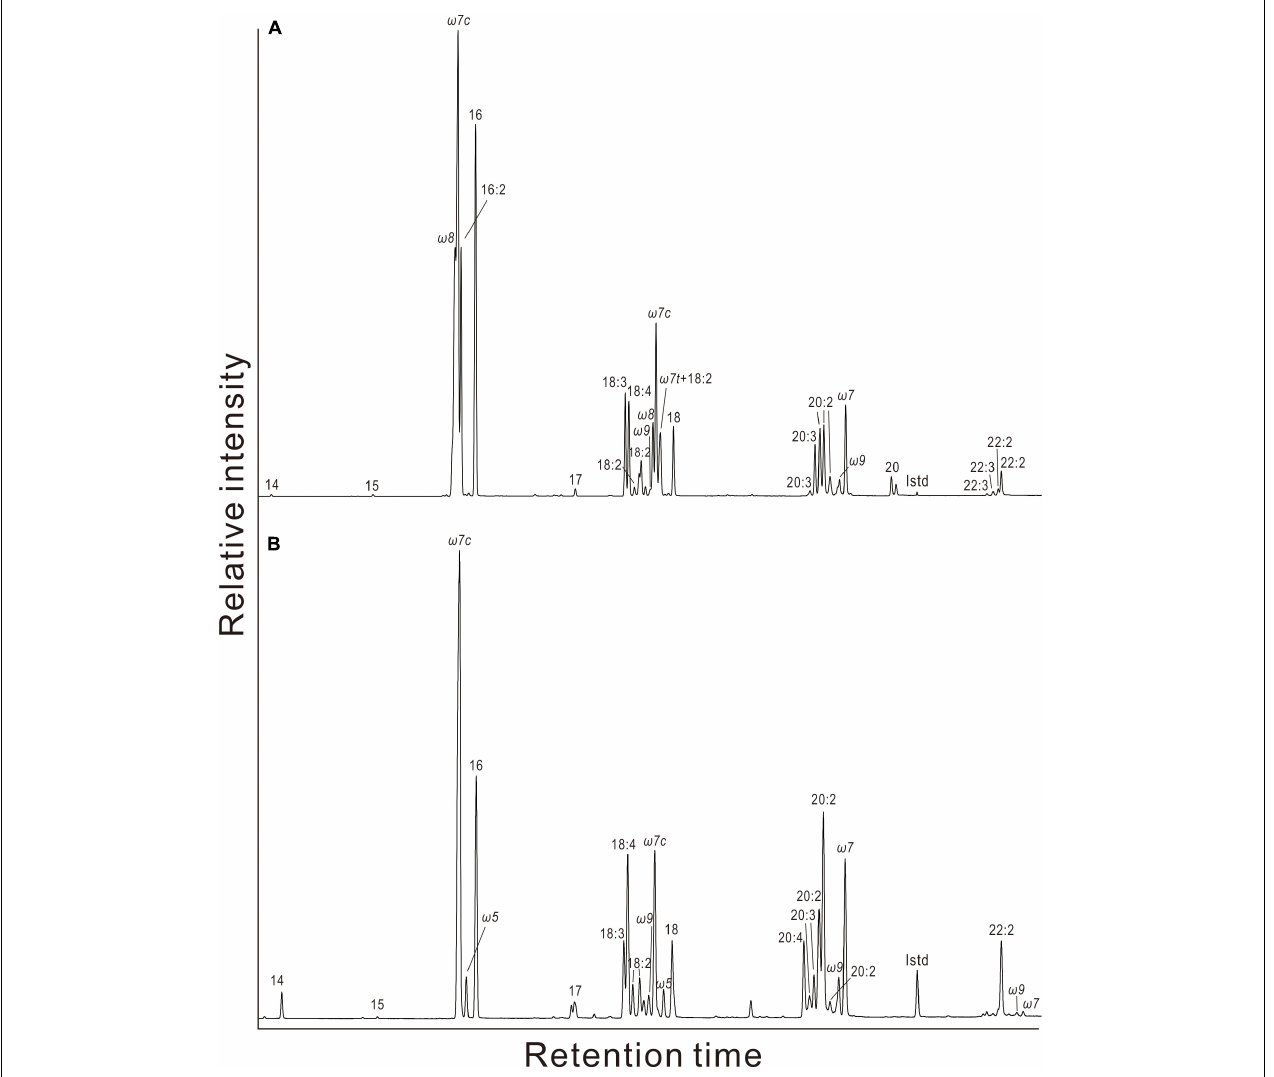
FIGURE 3 | Partial gas chromatograms of fatty acids in gill tissues of (A) Gigantidas platifrons and (B) Bathymodiolus aduloides. The ω indicates the double bond position of monounsaturated fatty acids (MUFAs), the suffix c is for cis and t for trans , referring to stereoisomers of MUFAs. Double bond positions of polyunsaturated fatty acids (PUFAs) have not been